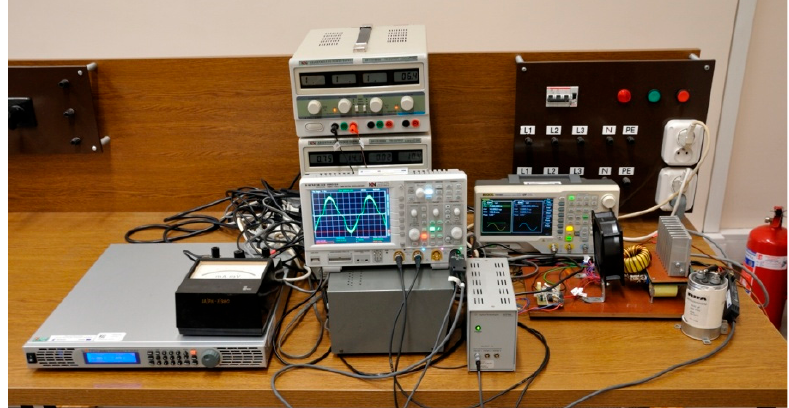
Figure 8. Laboratory setup.